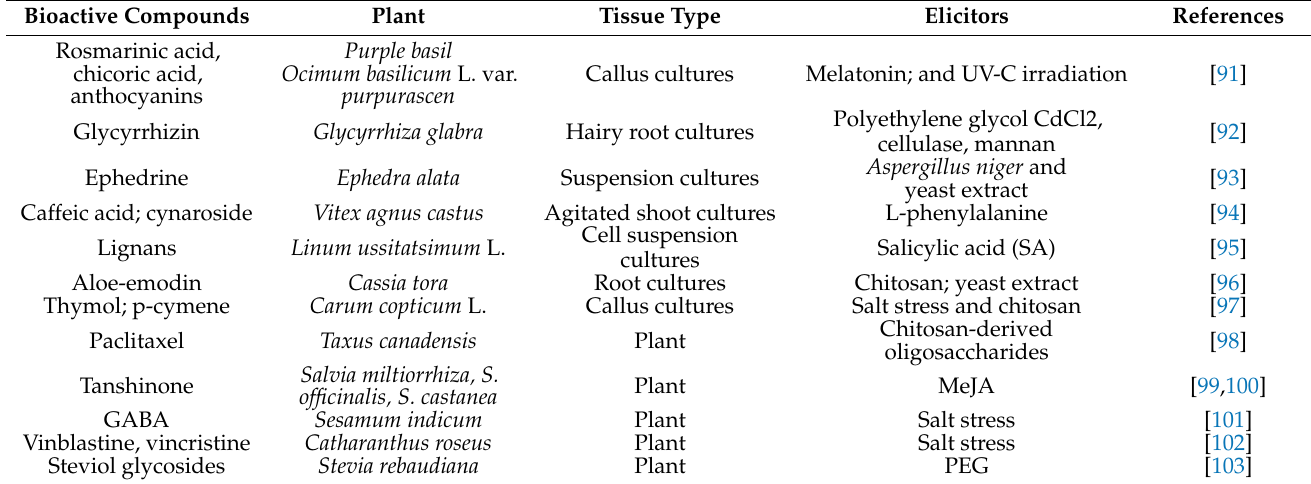
Table 3. Promising elicitation strategies used for improvement of plant-derived compounds in plant cell and organ cultures modified from